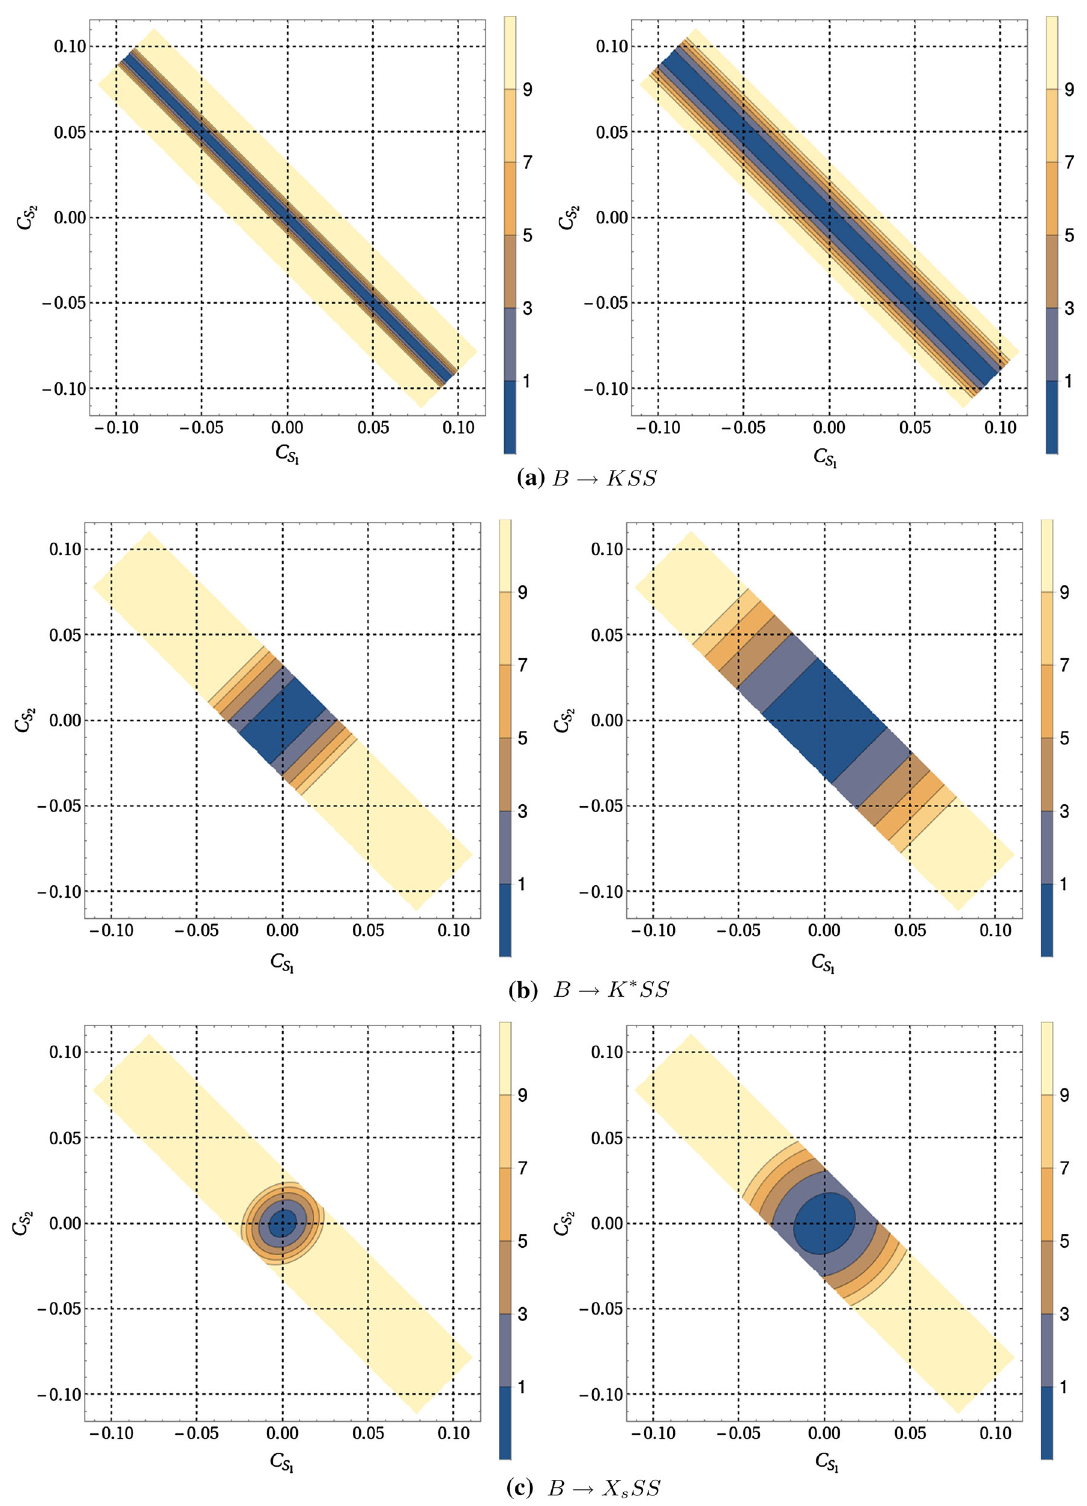
Fig. 7 Same as Fig. 5 with m S = 1 . 8